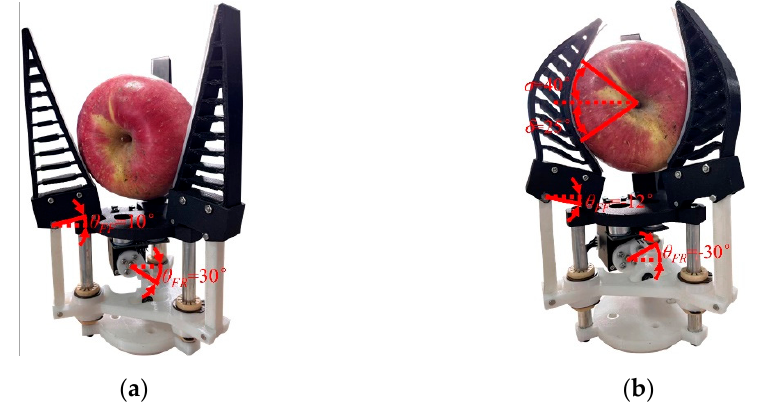
Figure 20. Contact model of soft gripper: ( a ) initial contact; ( b ) full contact.